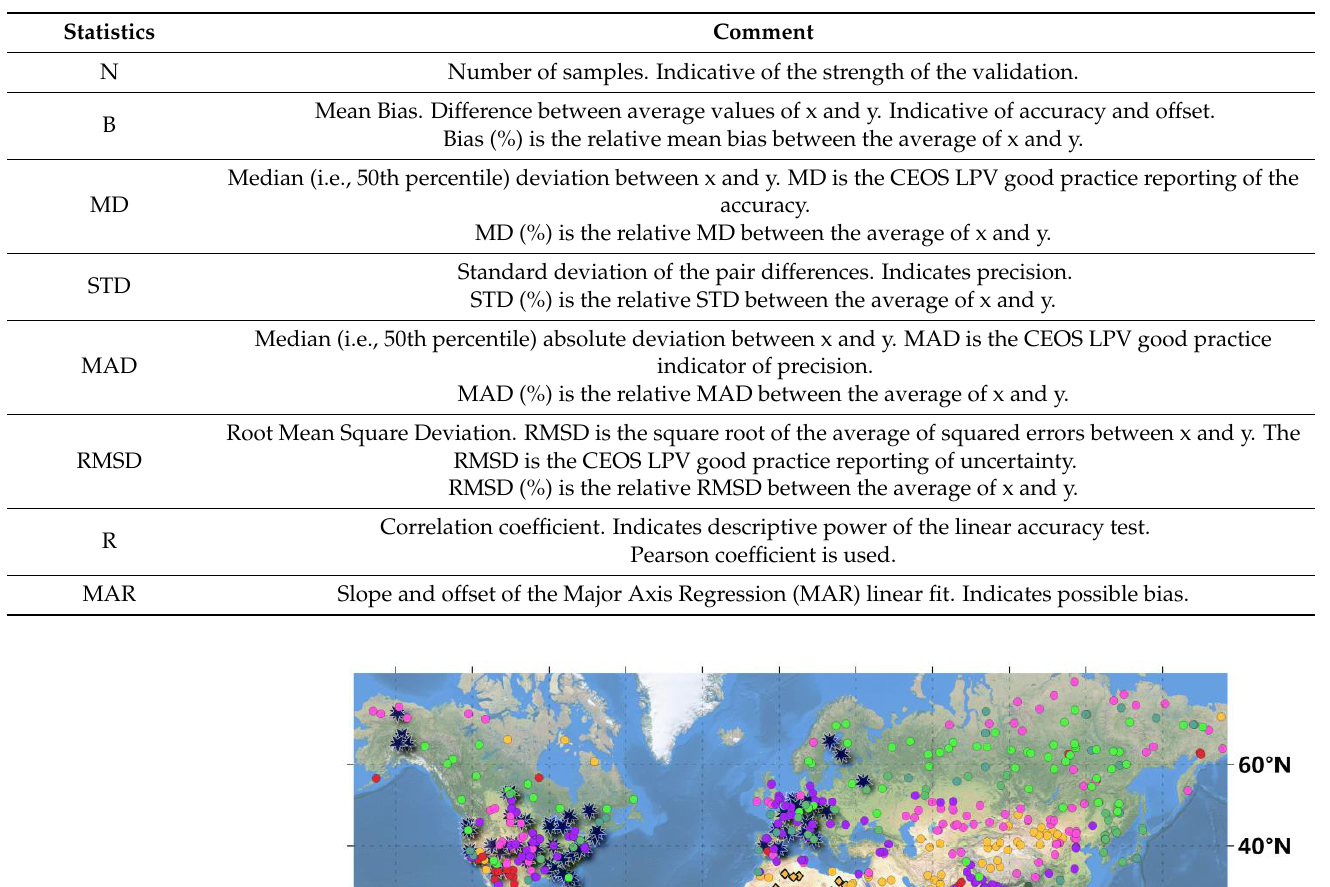
Table 3. APU validation metrics.